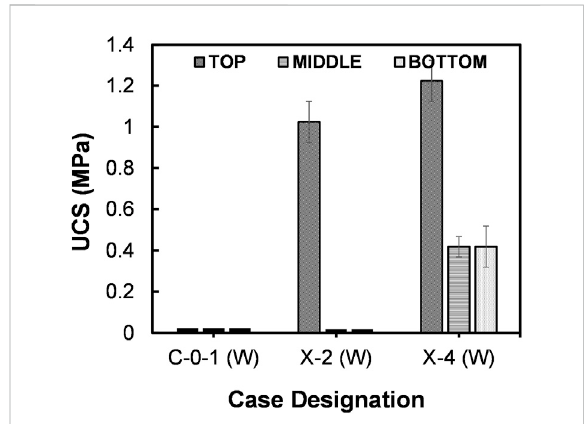
FIGURE 7 Comparison of UCS between MICP and B-EICP samples of silty sand – Watsu soil (where the case X-2 (W) is MICP, X-4 (W) is EB-EICP and C-0-1 (W) is the